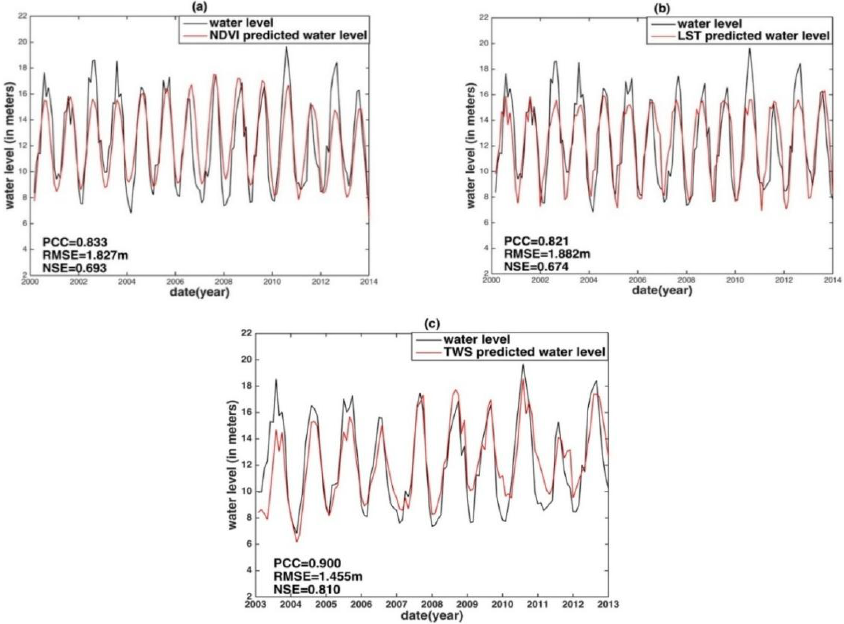
Figure 8. Water level prediction at the location of Hukou station based on ( a ) NDVI; ( b ) LST; and ( c ) TWS.